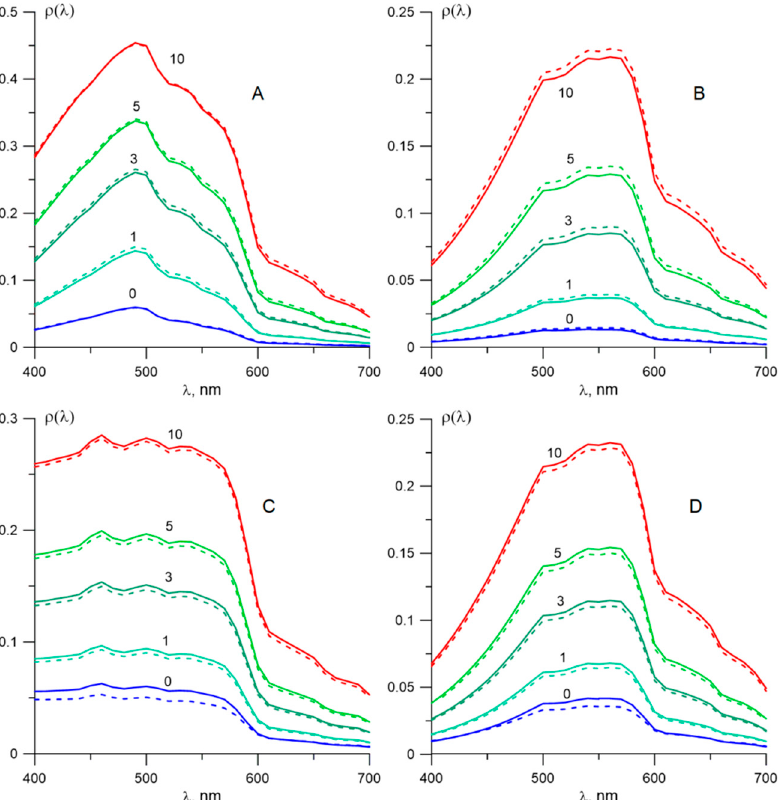
Figure 9. The spectra of the radiance reflectance as a function of the concentration of coccolithophores for the Black Sea ( A , B ) and the Barents Sea ( C , D ); the values of the absorption coefficient a (440) equal A, 0.09 m − 1 , B, 0.53 m − 1 , C, 0.18 m − 1 , D, 0.53 m − 1 . For the Black Sea, solid lines, θ 0 = 25°; dashed lines, θ 0 = 60 ◦ ; for the Barents Sea, solid lines, θ 0 = 60°; dashed lines, overcast. The numbers near the curves indicate N coc , 10 6 cell/L.